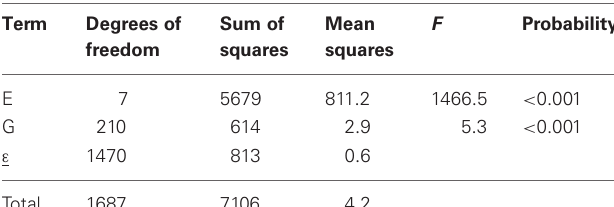
CIMMYT maize stress